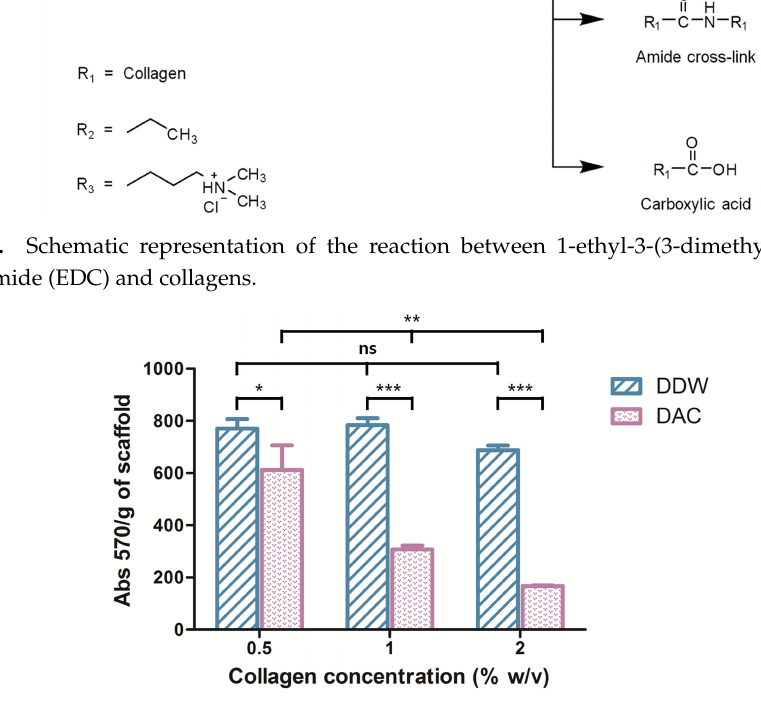
Figure 7. Free amine index of porous scaffolds. *** p < 0.001, ** p < 0.01, * p < 0.05, ns p > 0.05.